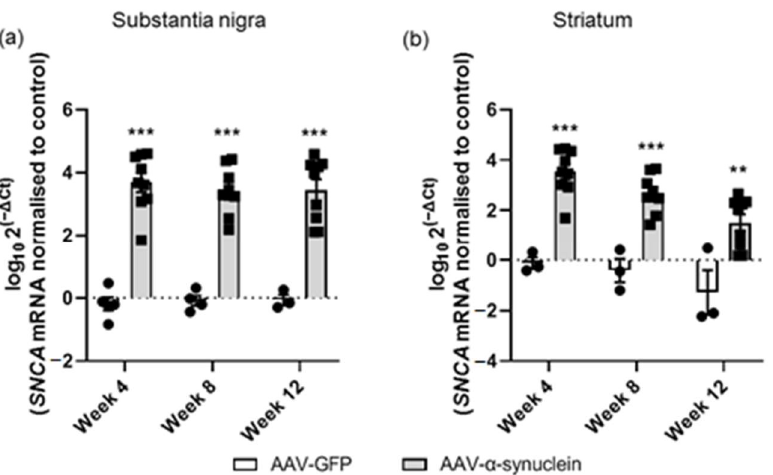
Figure 3. qRT-PCR analyses of human α -synuclein mRNA in the nigrostriatal pathway. The administration of AAV- α -synuclein induced a significant upregulation of human α -synuclein mRNA in ( a ) the substantia nigra and ( b ) in the striatum across all time-points. Data are represented as mean ± SEM with 3–9 animals per group. ** p < 0.01, ** * p < 0.001 vs. AAV-GFP by two-way ANOVA with post hoc Tukey.